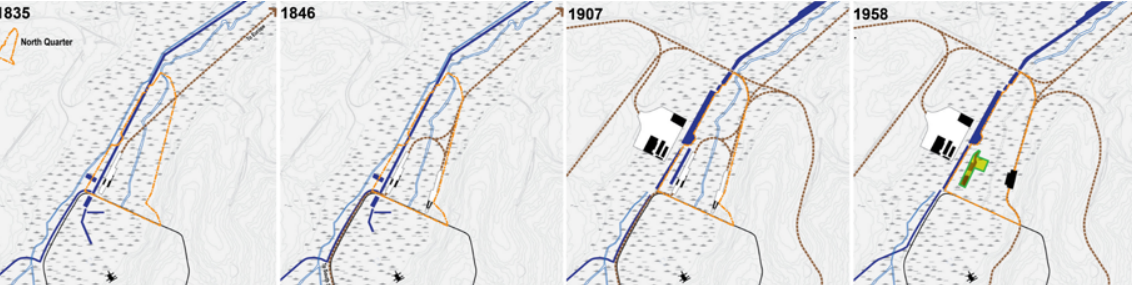
The North Station has a history of relocation linked with the Maximilian Park site, the former site of the Allee Verte Station. (1a) Allee Verte Station: the first station on the passenger rail connecting Brussels to Europe is constructed. (1b) The first North Station is constructed to increase the passenger capacity not fulfilled by Allee Verte, which soon became exclusively used for freight. (1c) Tour et Taxis becomes the major freight terminal, diminishing the role of the Allee Verte. The canal is widened, the industrial port expanded and the basin constructed. (1d) The new North Station is constructed to increase passenger capacity. The first North Station is gone and the river is covered. The Allee Verte and the basin are replaced by a heliport, where Maxilimian Park is today located. Maps by Racha Daher, based on historic maps of by the Cartographic Military